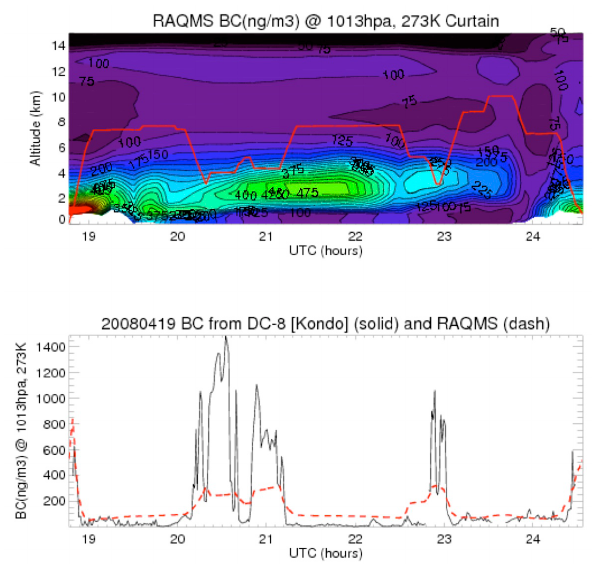
Figure 7: RAQMS Black Carbon (BC) profile and comparison between RAQMS (dotted line) and in situ (solid line) BC concentrations during DC8 flight 11 Fig. 7. RAQMS Black Carbon (BC) profile and comparison be- tween RAQMS (dotted line) and in situ (solid line) BC concentra- tions during DC8 flight 11.